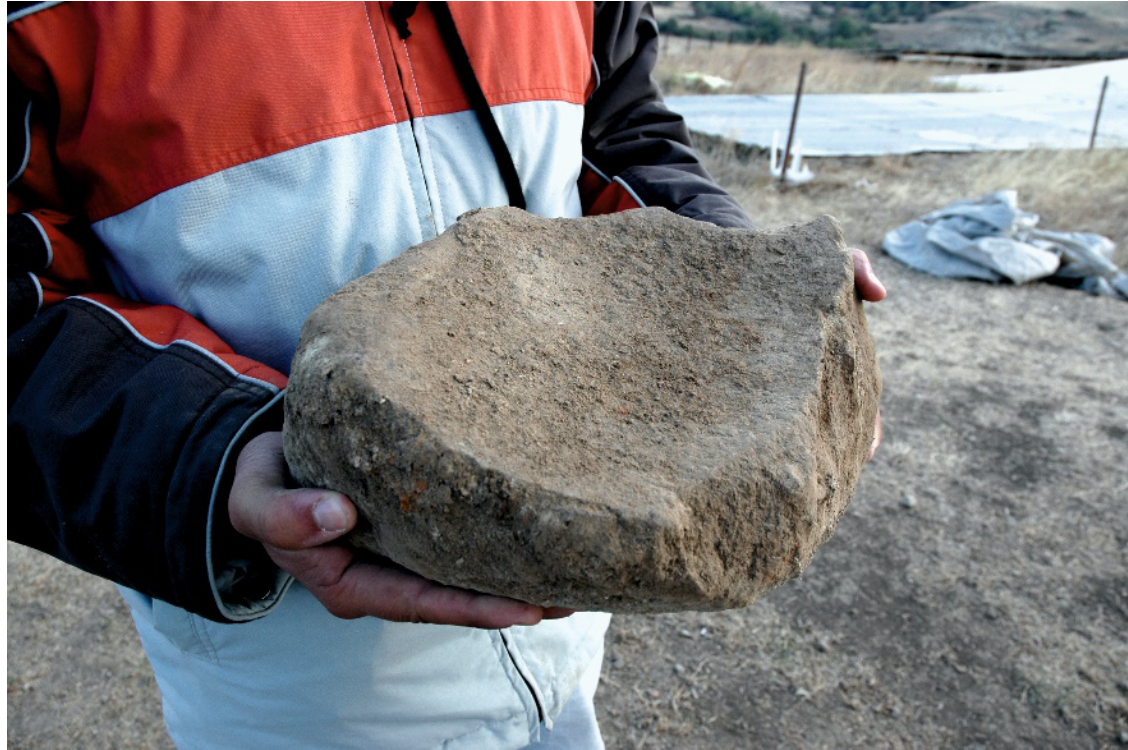
Figure 5. Grinding slab with a concavity from an AVGI III